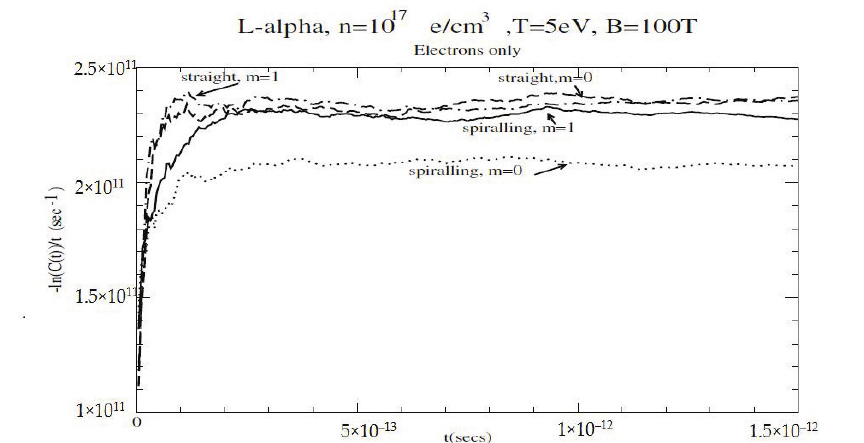
Figure 3. Plot of the quantity − lnC ( t ) / t , which is seen to saturate for large t, indicating that an impact form has set in. The conditions were n = 10 17 e/cm 3 , T = 5 eV and B = 100 T. 10,000 configurations were used in this run. m refers to the magnetic quantum number of the | 21 m (cid:104) spherical states, i.e., the σ ( m = 1 ) and π ( m = 0) components of the autocorrelation function C ( t ) , as the lower level is not broadened.